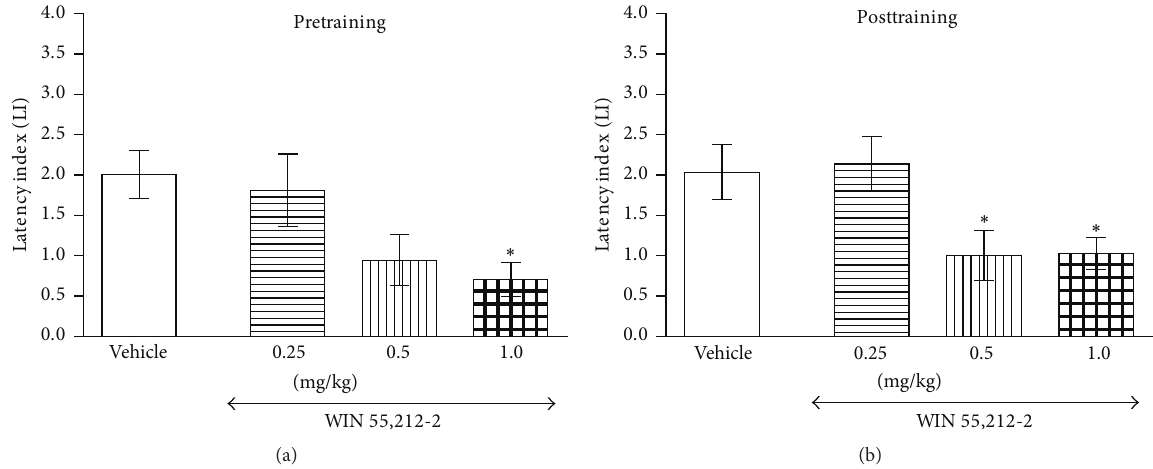
Figure 2: Effects of acute pretraining (a) or posttraining (b) CB1/CB2 receptor agonist WIN 55,212-2 or saline administration on the latency index (LI) in the PA test in mice. WIN 55,212-2 (0.25, 0.5, and 1.0 mg/kg; ip) or vehicle was administered 30 min before the first trial (a) or immediately after the first trial (b) and the mice were retested 24 h later; 𝑛 = 8 – 12 ; the means ± SEM; ∗ 𝑝 < 0.05 versus vehicle-treated control group; Tukey’s